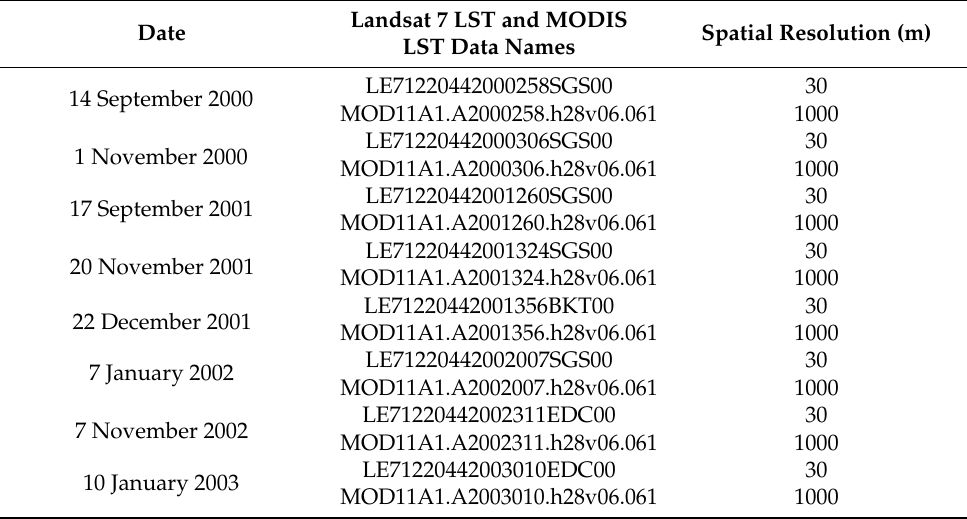
Table 1. Data list of Landsat 7 LST and MODIS LST products used in the study